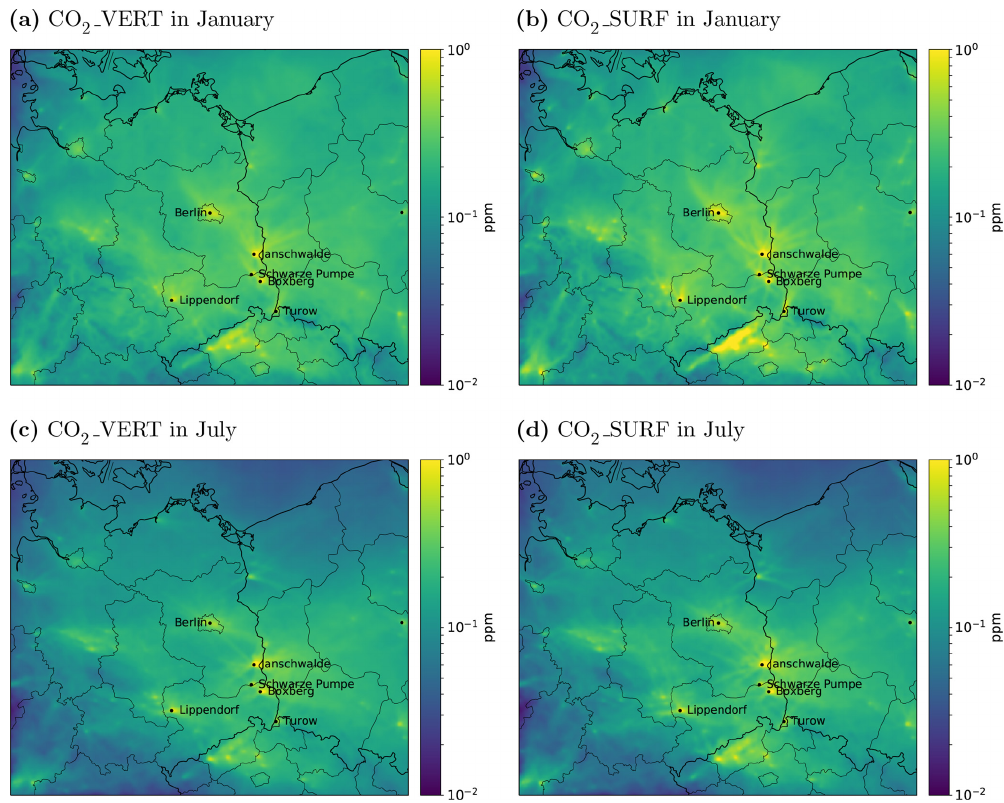
Figure 9. Column-averaged dry air mole fractions (XCO 2 ) at 11:30LT in (a, b) January and (c, d) July contributed by all anthropogenic sources in the domain. (a, c) Tracer CO2_VERT released according to realistic vertical profiles. (b, c) Tracer CO2_SURF released only at the surface.